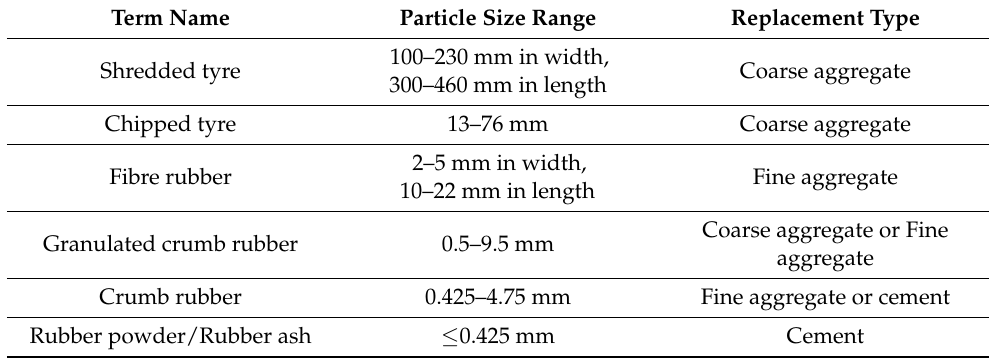
Table 4. Classification of the rubber particles